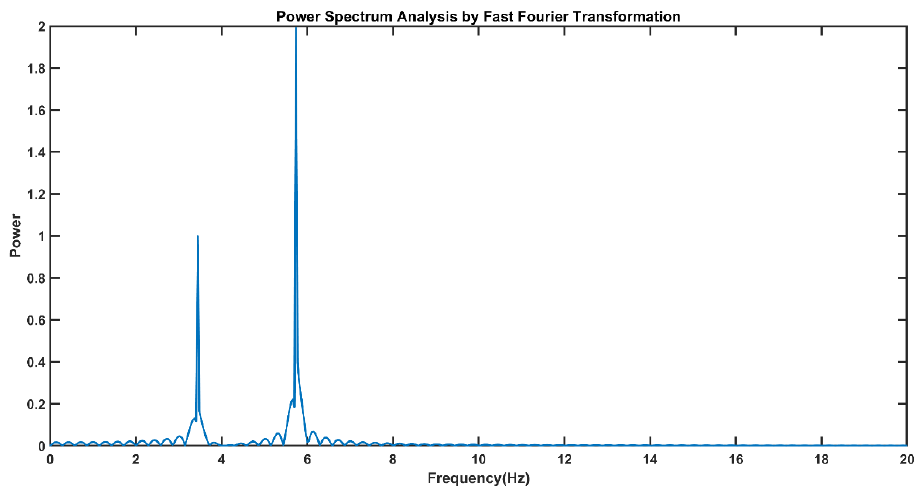
Figure 8. The fast Fourier transform (FFT)-based power spectrum shows that the simulated signal contains two frequencies at 3 Hz and 5 Hz, in which the power of the 5-Hz component is higher than that of the 3-Hz signal component.